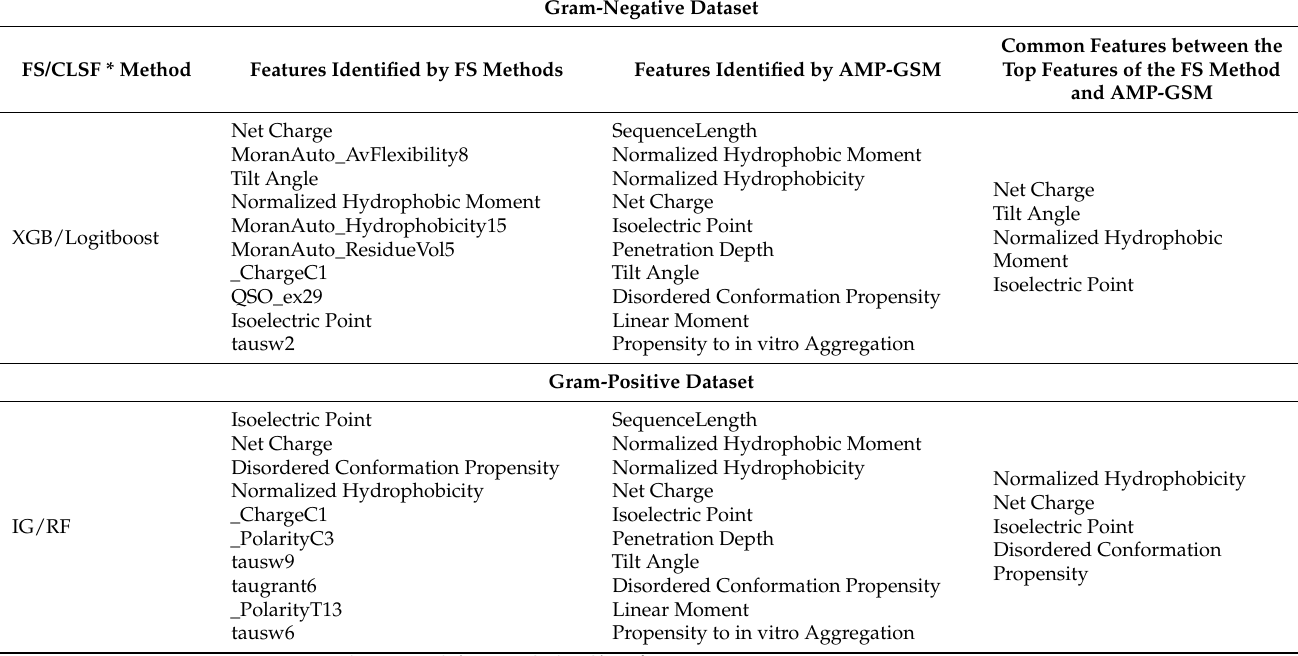
Table 8. Comparison of the most important 10 features found in the fi rst two groups in the AMP-GSM method with the 10 most informative features identi fi ed by the feature selection methods for Gram-negative and Gram-positive datasets.